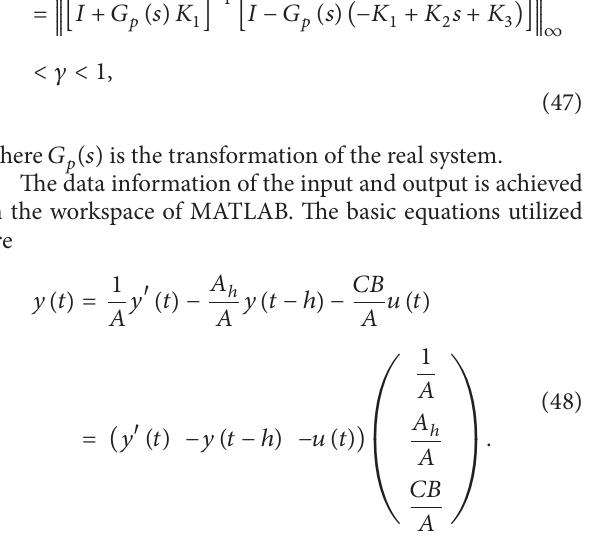
𝐴 = −1 , and 𝑏 = 7/10 . Both 𝜐 ℎ noises. Besides, let the learning gains be 𝐾 1 = 4/5 , 𝐾 2 = 1/10 , and 𝐾 3 = 1/2 are controller gains, 𝑑 𝑘 (𝑡) is the time varying